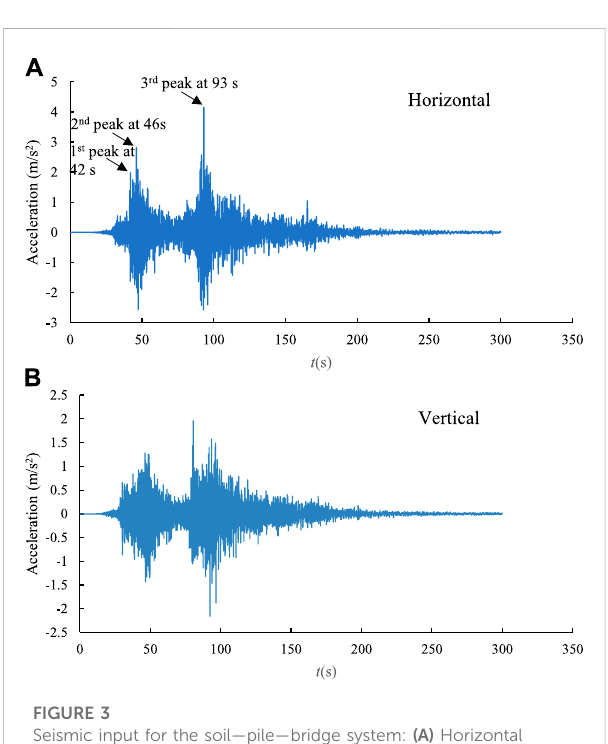
FIGURE 3 Seismic input for the soil — pile — bridge system: (A) Horizontal excitation and (B) vertical excitation.